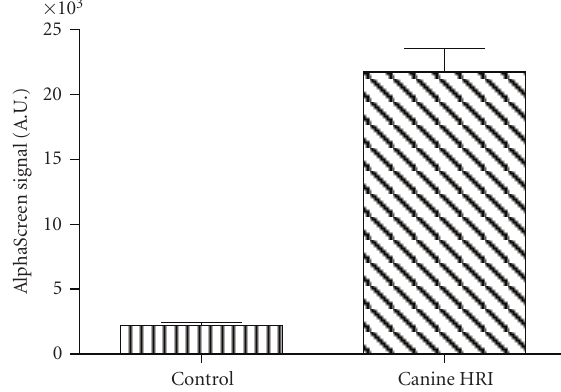
Figure 4: Kinase activity of recombinant canine HRI. Kinase activity of canine HRI was determined by an in-vitro kinase assay using purified canine HRI and a kinase peptide substrate. The experiment was performed in triplicate with the mean ± SEM